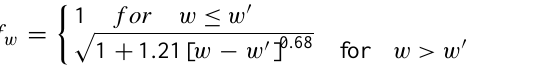
Fig. 5. Total average relative surface for the four populations of particles over northern 3 Africa. 4